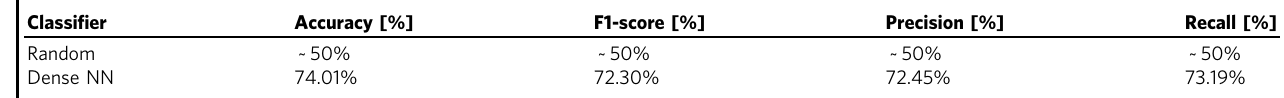
Table 3 WCNC classi fi cation performance vs. random classi fi